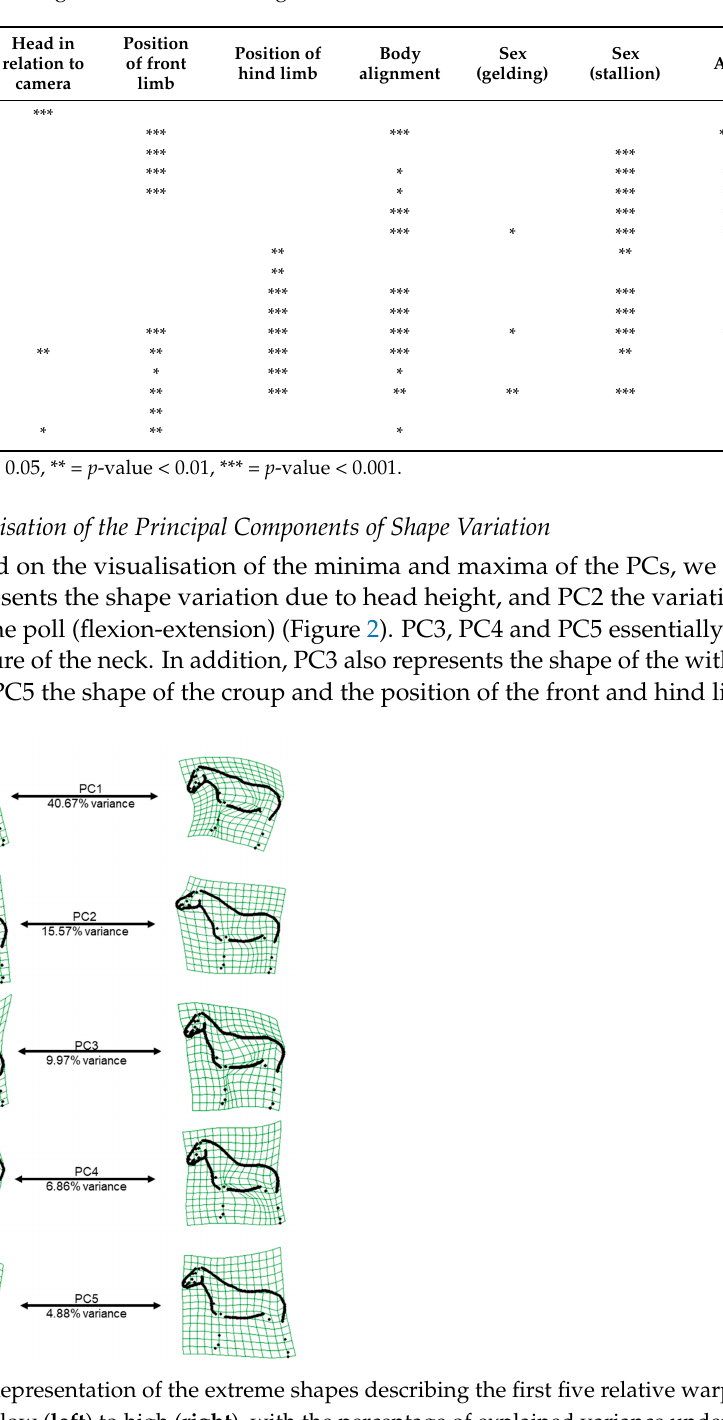
Table 3. Summary table of the significance of the postural variables, sex, age and year of birth on the different joint angles based on linear regression.